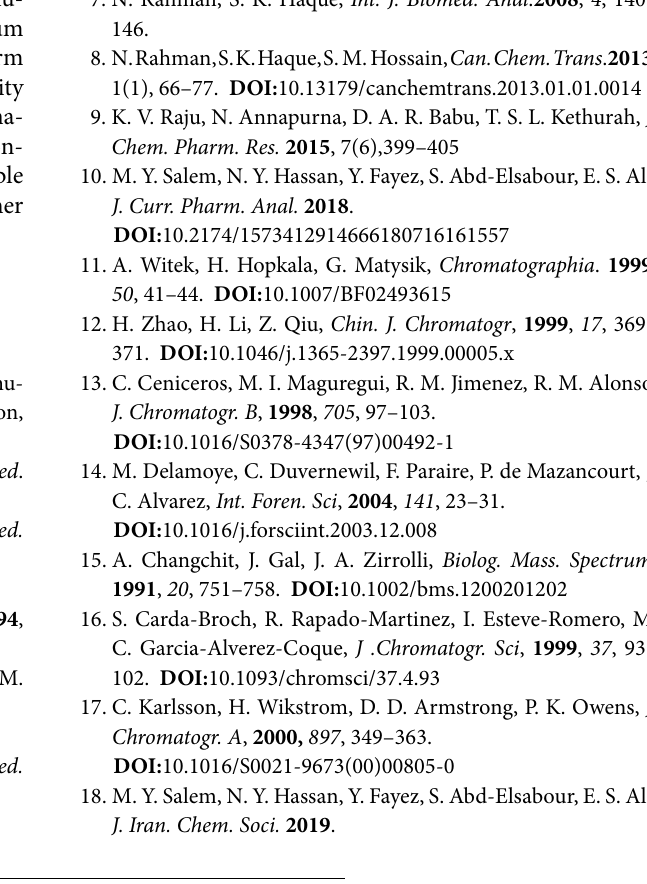
Table 4. Statistical comparison of results obtained by the proposed sensors and the official method for determination of Lab in pure form. Items Offical method 1 sensor